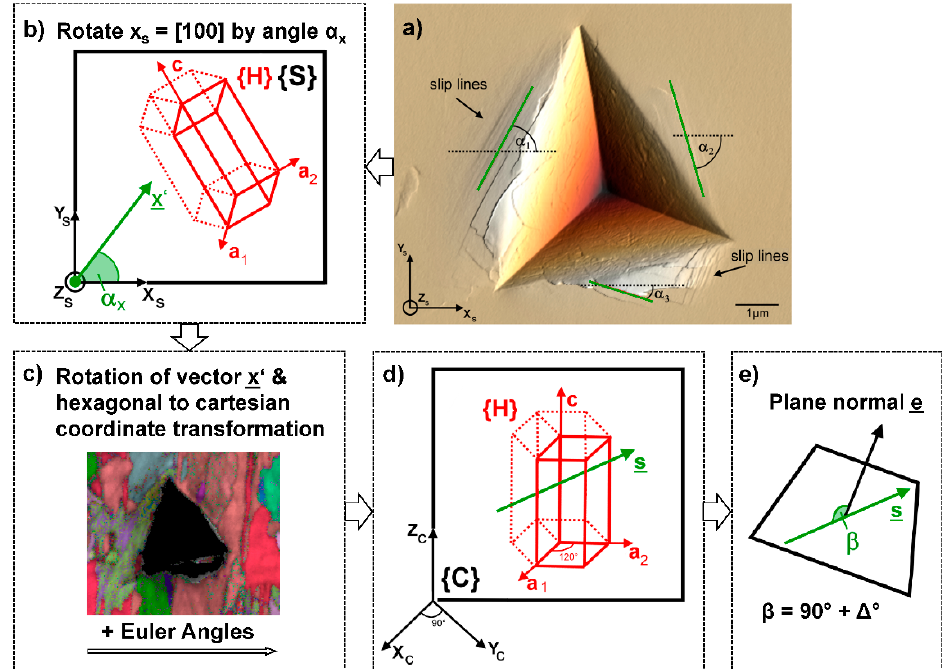
Figure 3. Schematic representation of the surface trace analysis: ( a ) angular measurement of traces. ( b ) rotation of sample image horizontal ( x -axis) to obtain trace vector. ( c ) Further rotation by Euler matrix and hexagonal to cartesian transformation, show in ( d ) as the vector in crystal coordinates. ( e ) If the dot product of plane normal and vector equals 90 ◦ ± ∆ the observed surface trace lies within plane. The indent in ( a ) is from a Fe 7 Mo 6 µ -phase sample produced by arc melting, annealed for 1000 h at 800 ◦ C and mechanically polished down to a colloidal silica finish. Image reproduced from